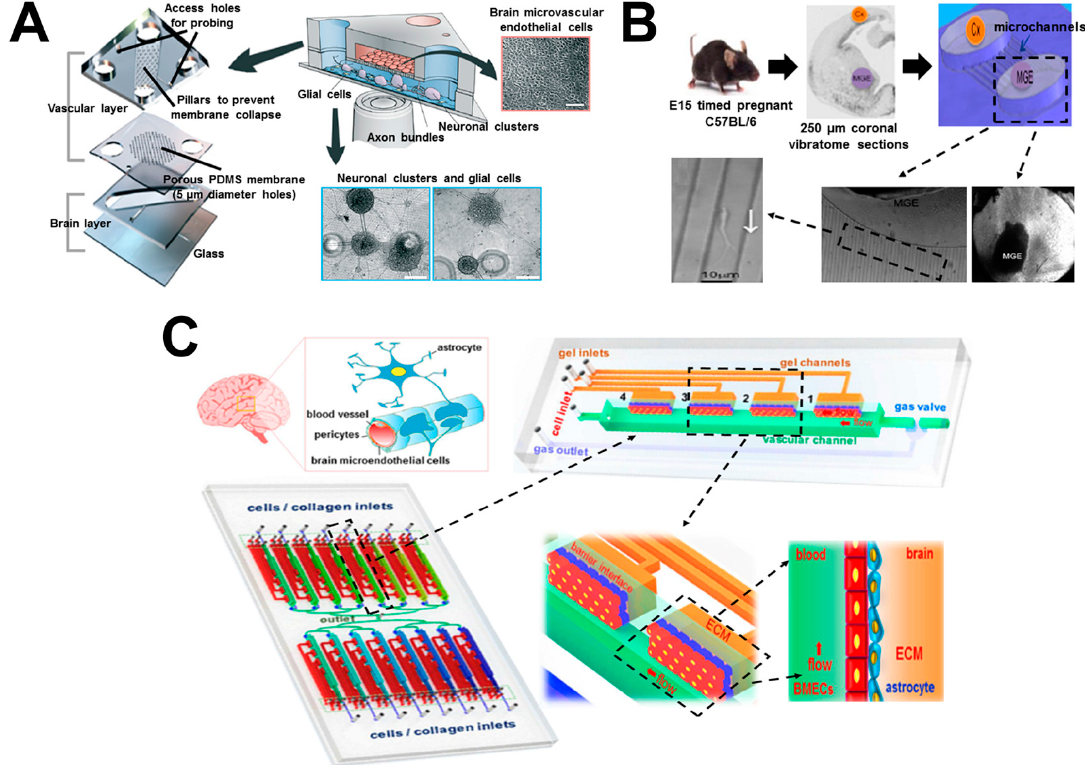
Figure 6. Examples of brain-on-chip cell migration study. ( A ) The brain-on-chip model for investigating neuronal differentiation and chemotaxis. The image shows the detailed information of the microfluidic system. ( B ) The brain-on-chip model for investigating neuronal migration. The upper-left & middle panels show the mouse embryonic brain explants (Cx: cortex; MGE: medial ganglionic eminence); the upper-right panel shows schematic presentation of the microfluidic device; the bottom panel shows representative experimental images of the selective areas. ( C ) The brain-on-chip model for investigating brain tumor metastasis. The image shows the schematic illustration of blood–brain barrier (BBB) and the microfluidic system with magnified views of selective regions. Figure 6A was adapted from reference [49] with permission from the Royal Society of Chemistry; Figure 6B was adapted from reference [50] with permission from Elsevier; Figure 6C was adapted from reference [52] with permission from Nature Publishing Group. BMECs: brain microvascular endothelial cells.